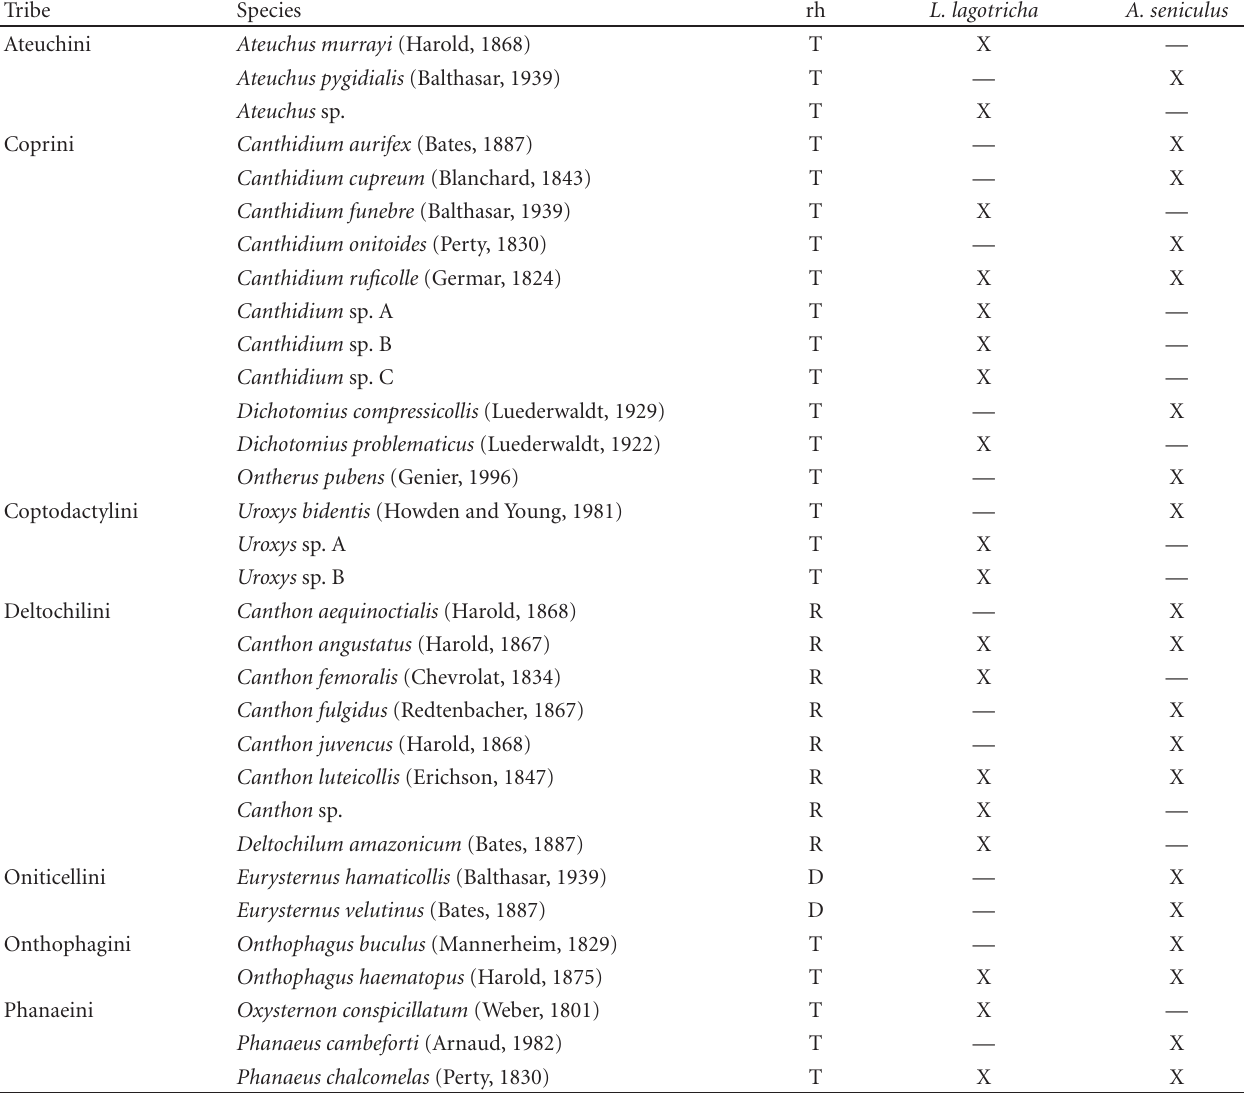
Table 1: List of the species associated with each of the primate’s dung, with their relocation habits (T: tunneler, R: roller, and D: dweller), in the CIEM station, Meta, Colombia. Tribe Species rh